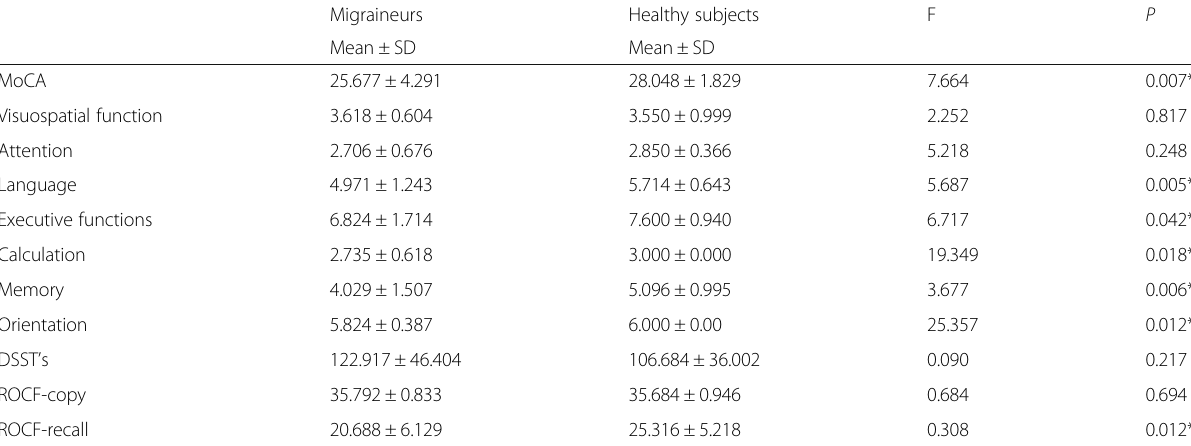
Table 2 The Cognitive Outcome measures between migraine group and control group Migraineurs Healthy